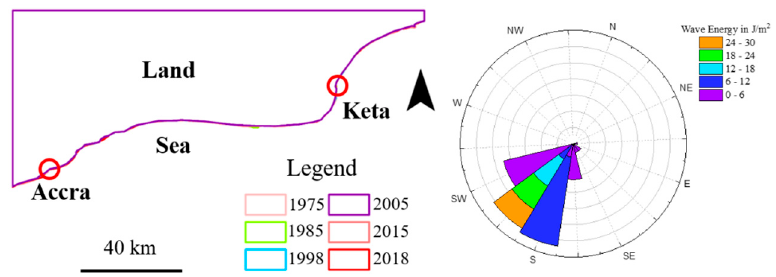
Figure 5. The shoreline changes from 1975 to 2018 of the Volta River Delta (adapted from Amenuvor et al. (2020) [19]).